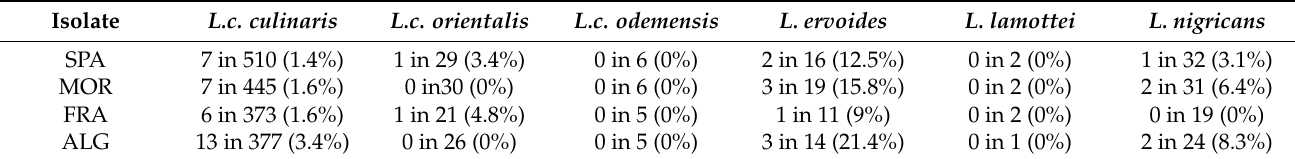
Table 4. Number of accessions showing hypersensitive response (IT < 3) across the various Lens species against the various isolates of U. viciae-fabae ex L. culinaris . Seedling tests under controlled